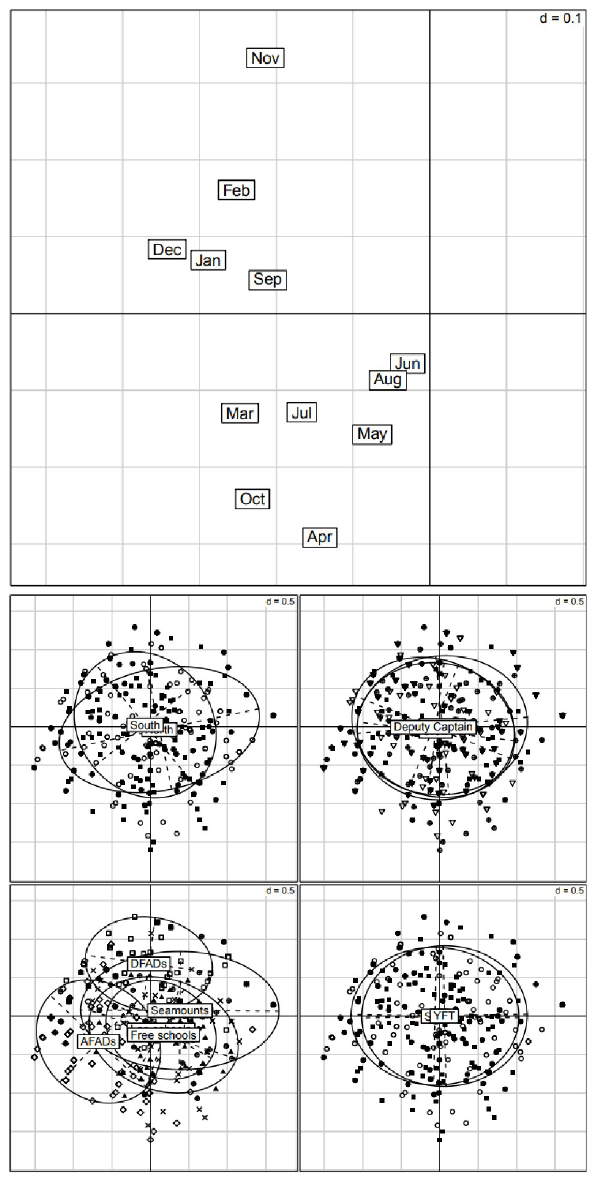
Fig 4. Results of the PCA on the monthly variability of tuna abundance. On the first two axes, representing respectively 20% and 14% of the total information, (A) projection of the 12 months and of the 540 rows grouped by: (B) Origin of the fisher—North (black squares), South (empty circles); (C) Position of the fisher—Captain (black square), Crew (empty triangles), Deputy Captain (crosses); (D) Type of school—AFADs (empty diamonds), DFADs (empty circles), Log Schools (black triangles), Free schools (black squares), Seamounts (crosses) and (E): species SKJ (black squares), YFT (empty circles). The value of d in the top-right corner gives the scale of the grid.